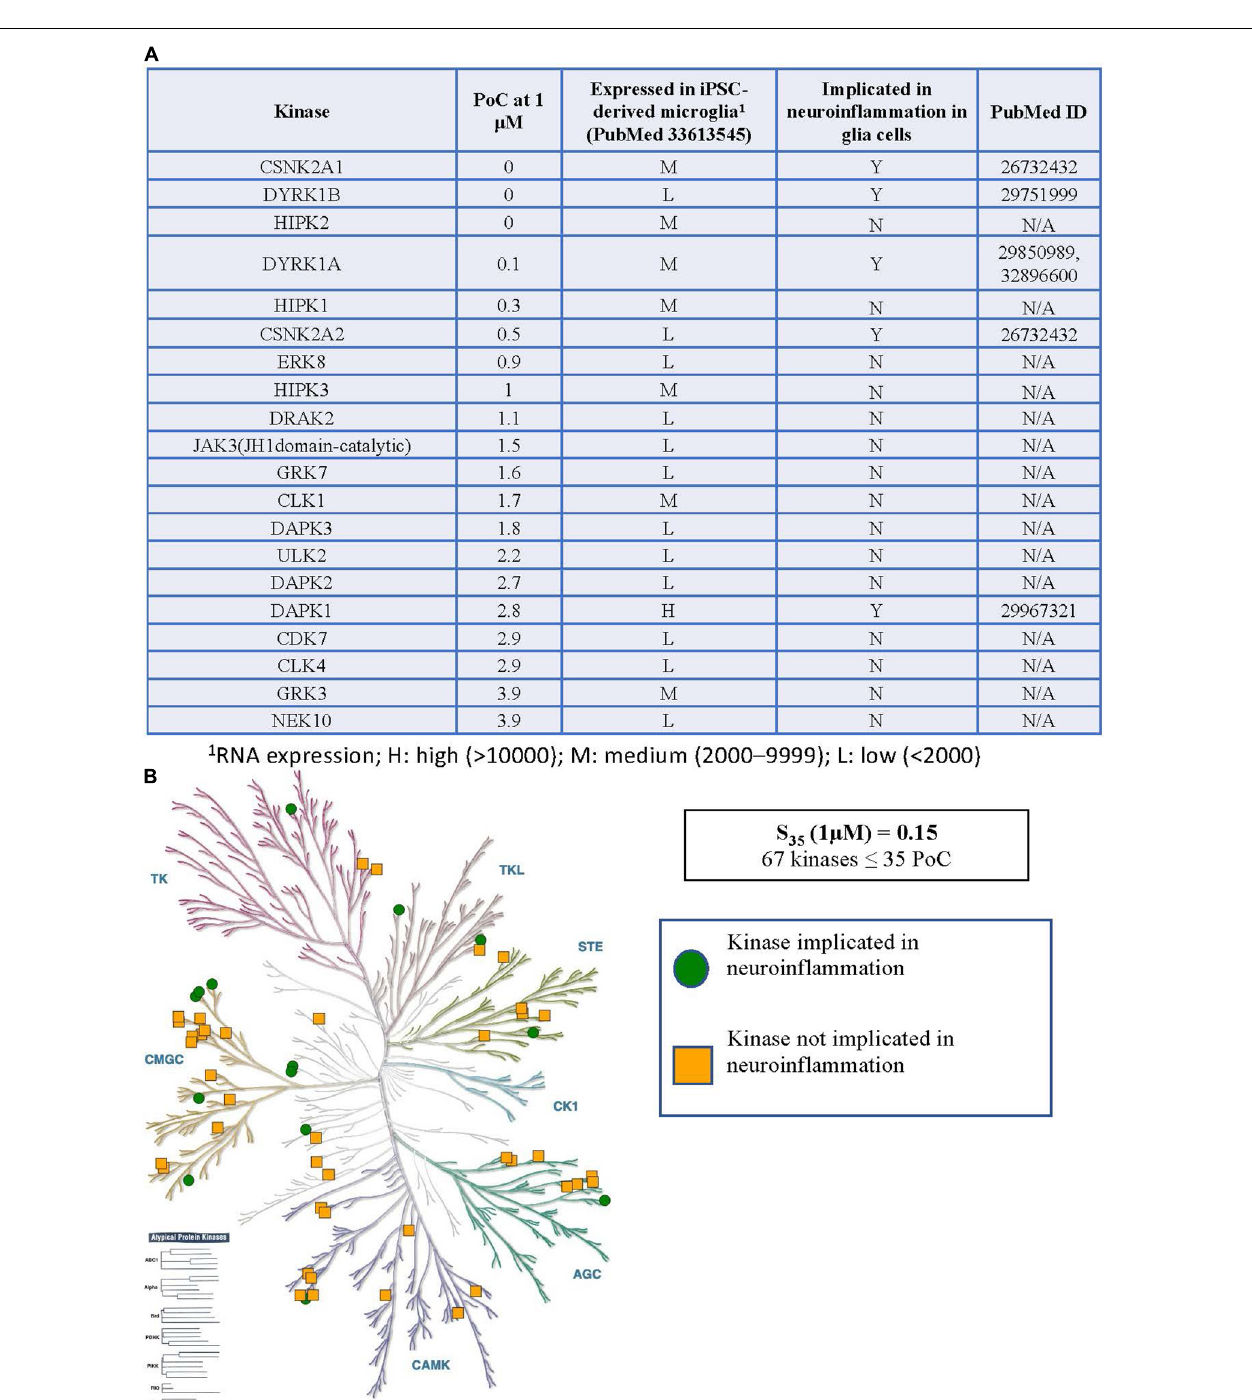
FIGURE 3 | Kinases inhibited by CX-4945 implicated in neuroinflammation. (A) Table of S 35 kinases with PoC < 5, expression of inhibited kinases in microglia, and reported connections to neuroinflammation in glial cells. (B) Visual representation of the distribution of all S 35 kinases around the kinome tree. 1 RNA expression; H, high ( > 10,000); M, medium (2,000–9,999); L, low ( < 2,000).